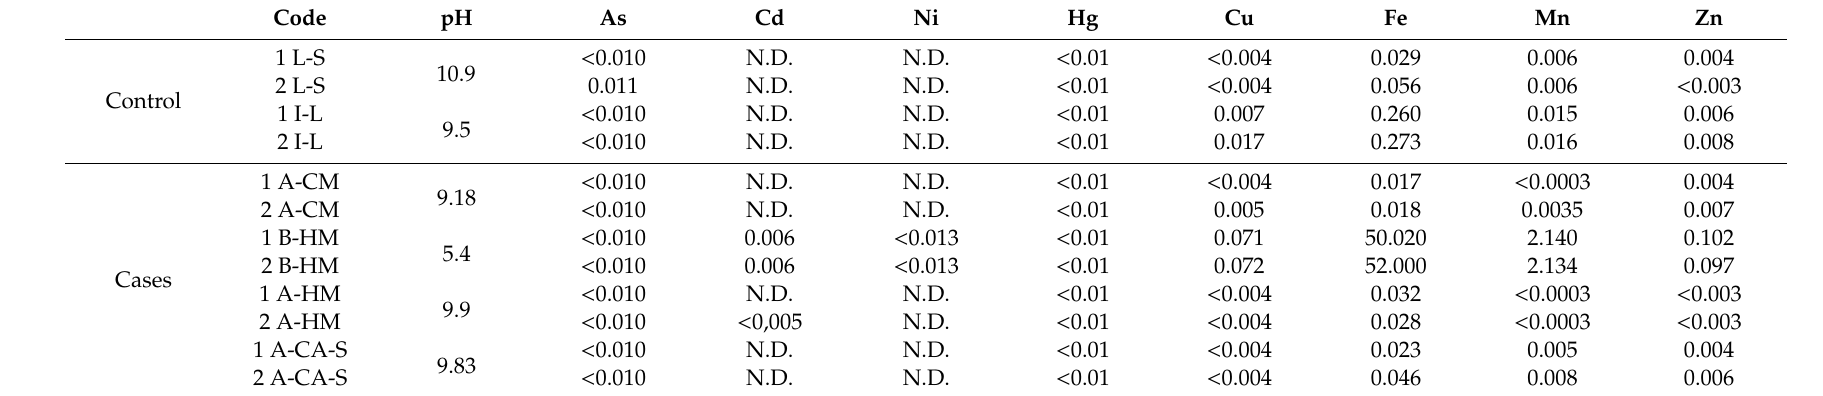
Table A4. Total metal concentrations (mg L − 1 ) in water samples in this research in Aimaraes sub-basin.